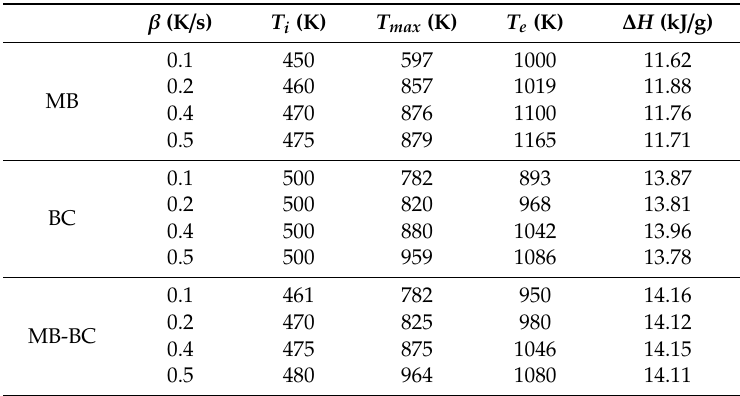
Table 6. Characteristic parameters of DSC combustion curves determined for microalgae biomass (MB), bituminous coal (BC) their blend